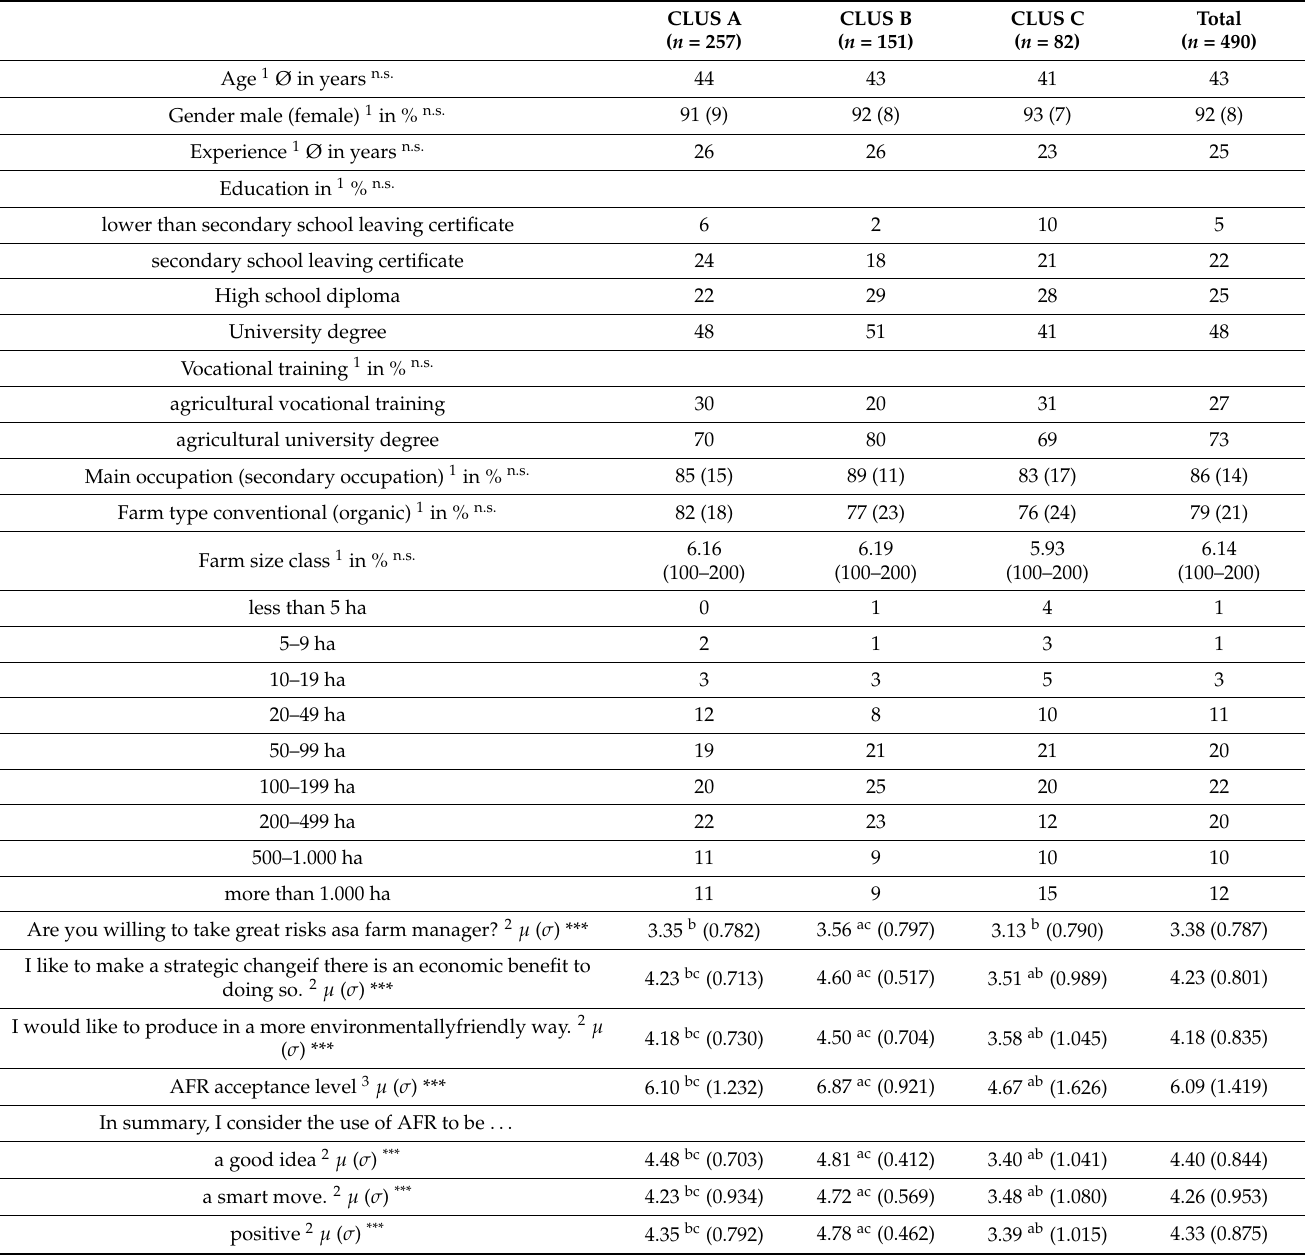
Table 3. Farmers’ characteristics inside the